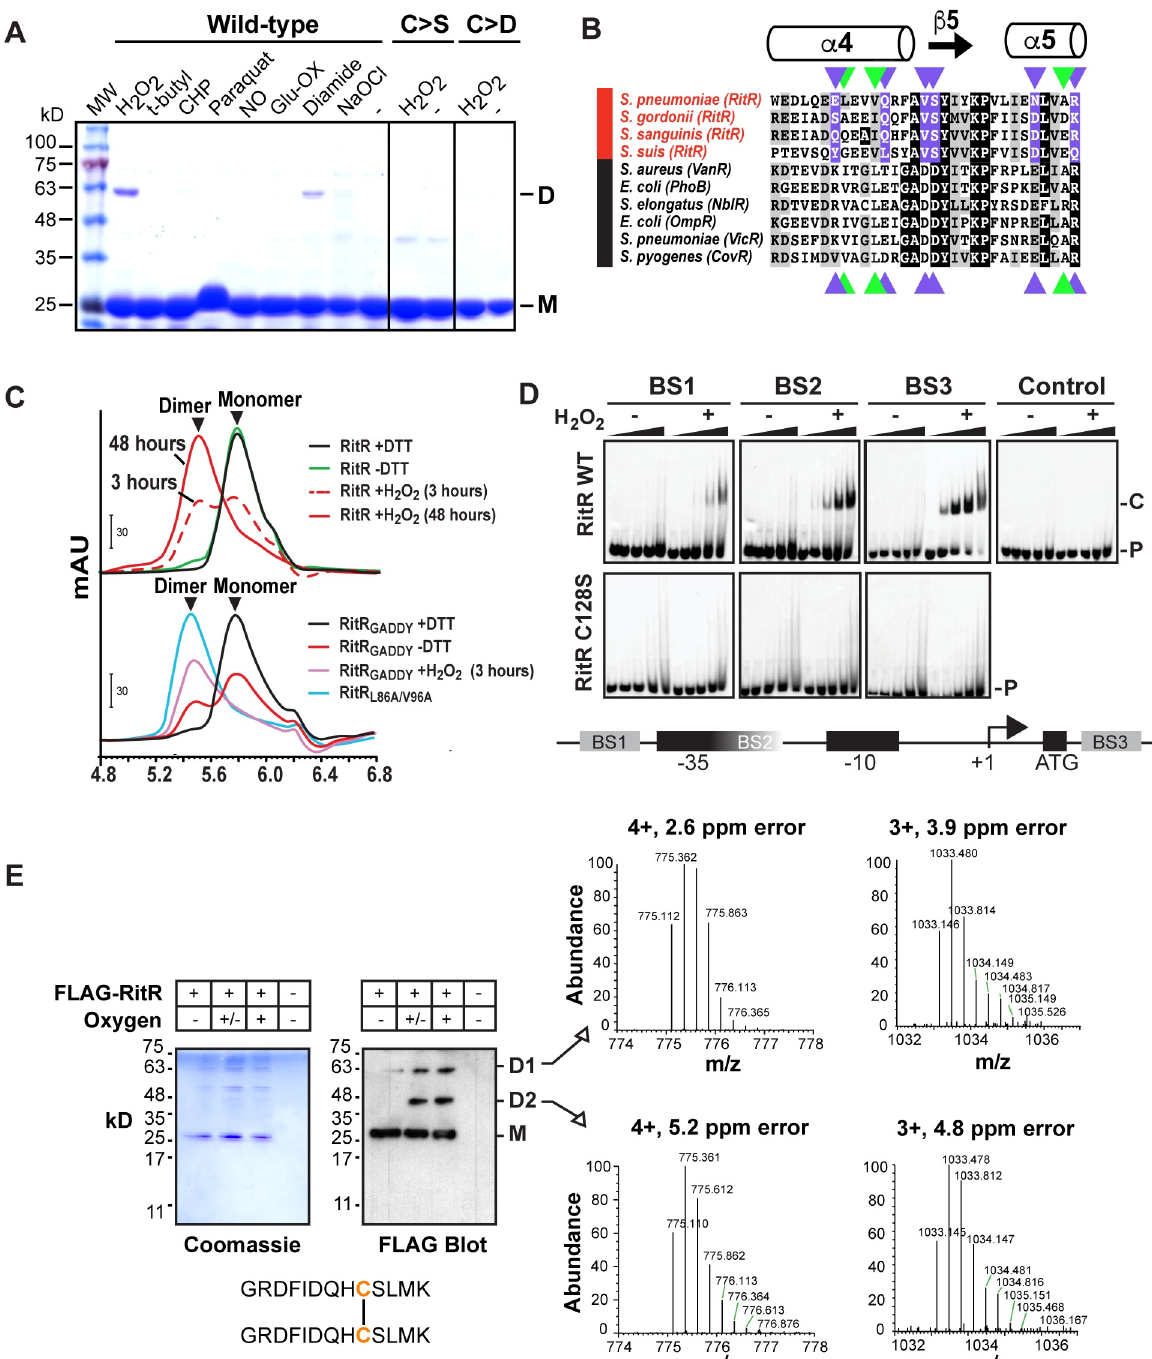
Fig 2. RitR has evolved to dimerize through Cys128-mediated oxidation by H 2 O 2 . ( A ) Non-denaturing SDS-PAGE gels of RitR WT, C > S and C > D mutants plus various oxidants in the presence of 3 mM DTT. D, dimeric RitR; M, monomeric RitR. MW, Molecular Weight ladder; H 2 O 2 , hydrogen peroxide; t-butyl, tert-butyl hydroperoxide; CHP, cumene hydroperoxide; NO, nitrous oxide; Ox-Glu, oxidized glutathione; NaOCl, sodium hypochlorite. ( B ) Alignment of REC/ALR α 4- β 5- α 5 dimerization domains [30] from RitR homologs (red) and canonical REC domain sequences (black). The black boxes are identical residues and the grey boxes are similar residues. Residues colored purple and green represent key charged and hydrophobic residues, respectively, involved in typical REC dimerization. Note that several of these key residues are changed in RitR homologs. ( C ) SEC of wild-type RitR with (+) or without (-) addition of DTT or H 2 O 2 (top graph), or RitR changed back to the canonical GADDY sequence (RitR GADDY ; bottom graph). For comparison, the RitR L86A/V96A mutant is shown, which naturally dimerizes without addition